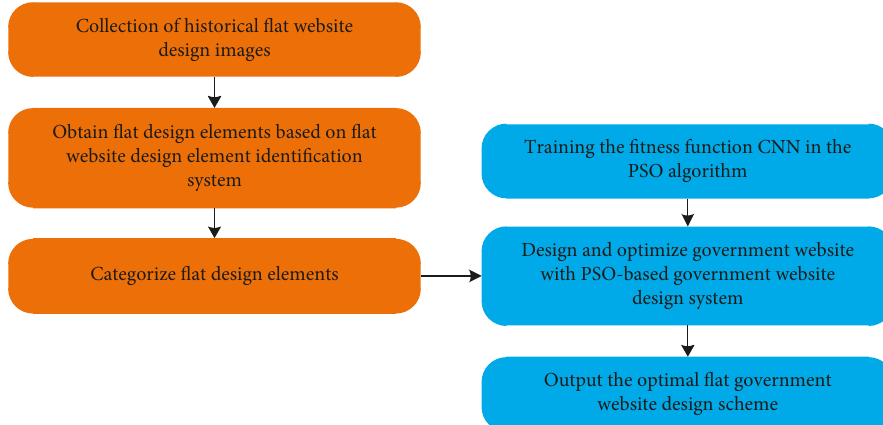
Figure 7: Workflow for the government website design